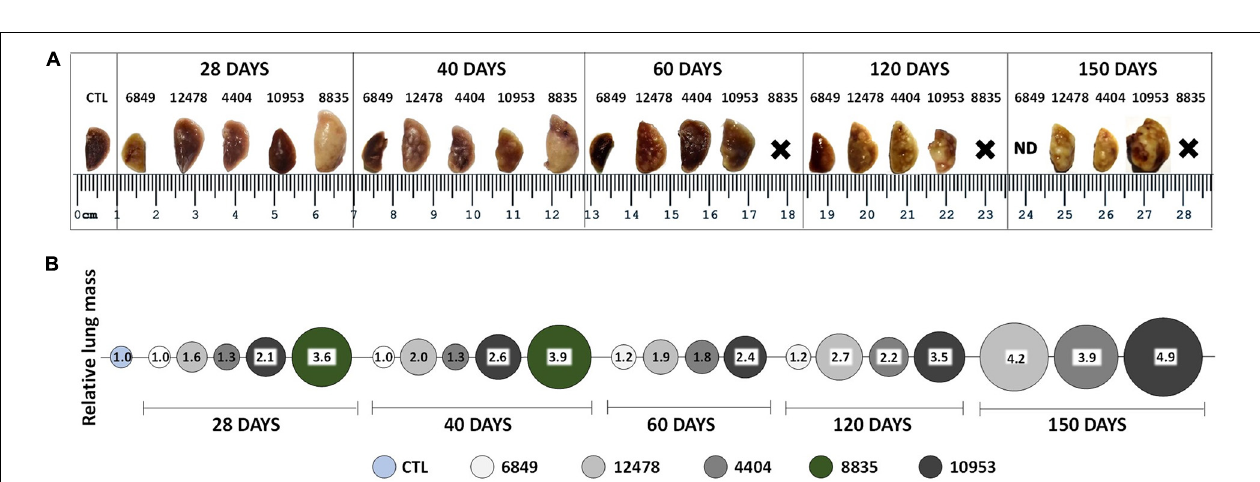
FIGURE 4 | Macropathological changes in the lungs of mice infected with Mycobacterium kansasii strains. C57BL/6 mice were infected as indicated in the Figure 3 legend, and lungs were examined on day 0, 28, 40, 60, 120, and 150 p.i. (A) Representative images of the upper lobe of the right lung demonstrating the gross pathology in animals of each infected group, observed as numerous giant inflammatory lesions (white nodes of different size). (B) Relative lung mass in different infected groups was determined by the ratio of the mean lung weight of animals in each group to the mean lung weight of control (CTL) animals (1.0). ND, not demonstrated; X-premature animal